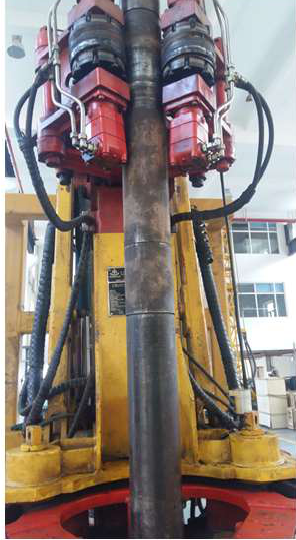
Figure 10. Experiment involving the spinner mechanism with single follow-up roller.